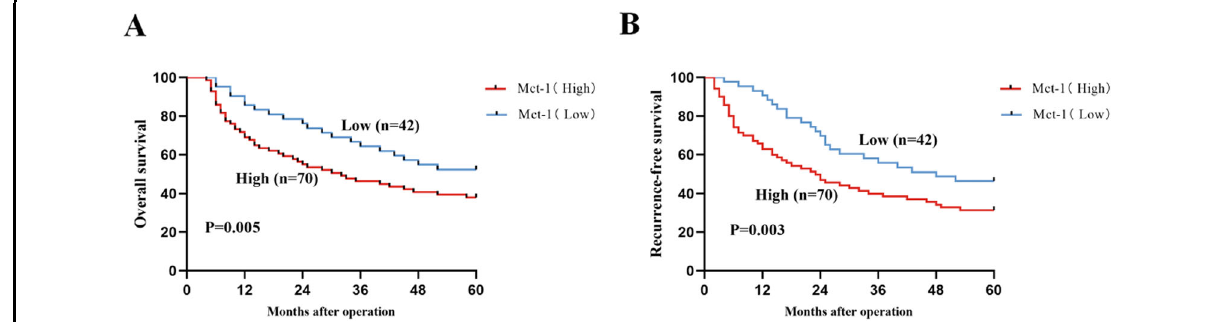
Fig. 2 Upregulated Mct-1 expression is predictive of a poor prognosis of HCC patients. Kaplan – Meier curves of OS ( A ) and RFS ( B ) of HCC patients based on Mct-1 expression